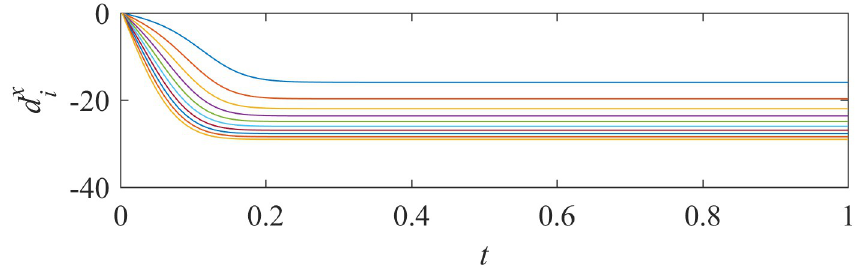
Fig 3. Trajectory of adaptive laws of sub-network X (Eq